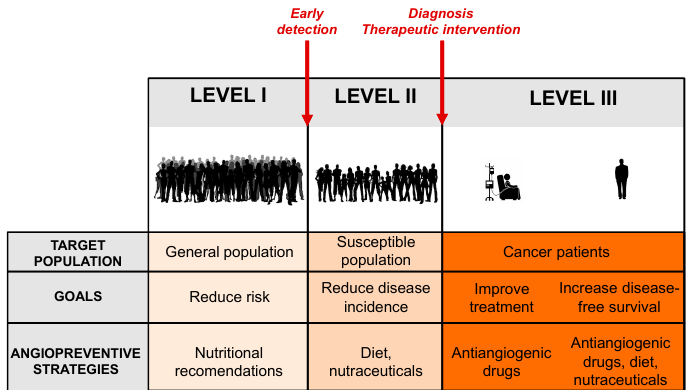
Figure 1. The three levels of cancer chemoprevention. The figure represents the three levels at which cancer preventive action could be implemented, showing the targeted population, the main goals, and the angiopreventive strategies at each level.